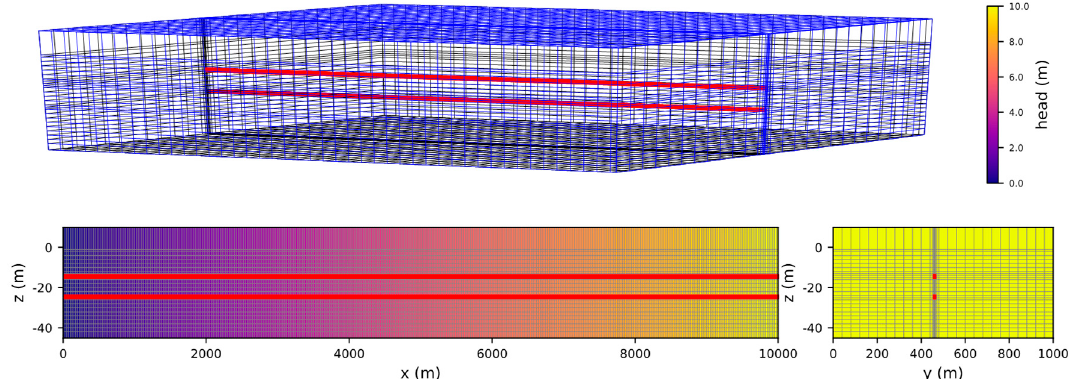
Figure 3. Three-dimensional grid used for the numerical simulations. The two red parallel lines correspond to the karst conduits. This figure was generated using FloPy [32].